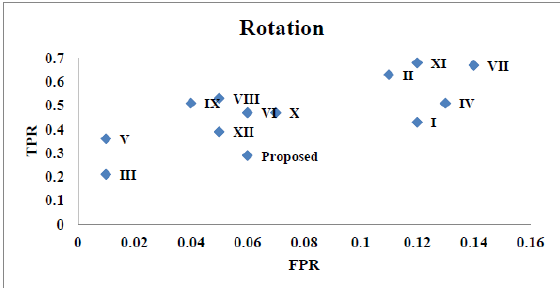
Figure 8. TPR vs. FPR: Rotation.